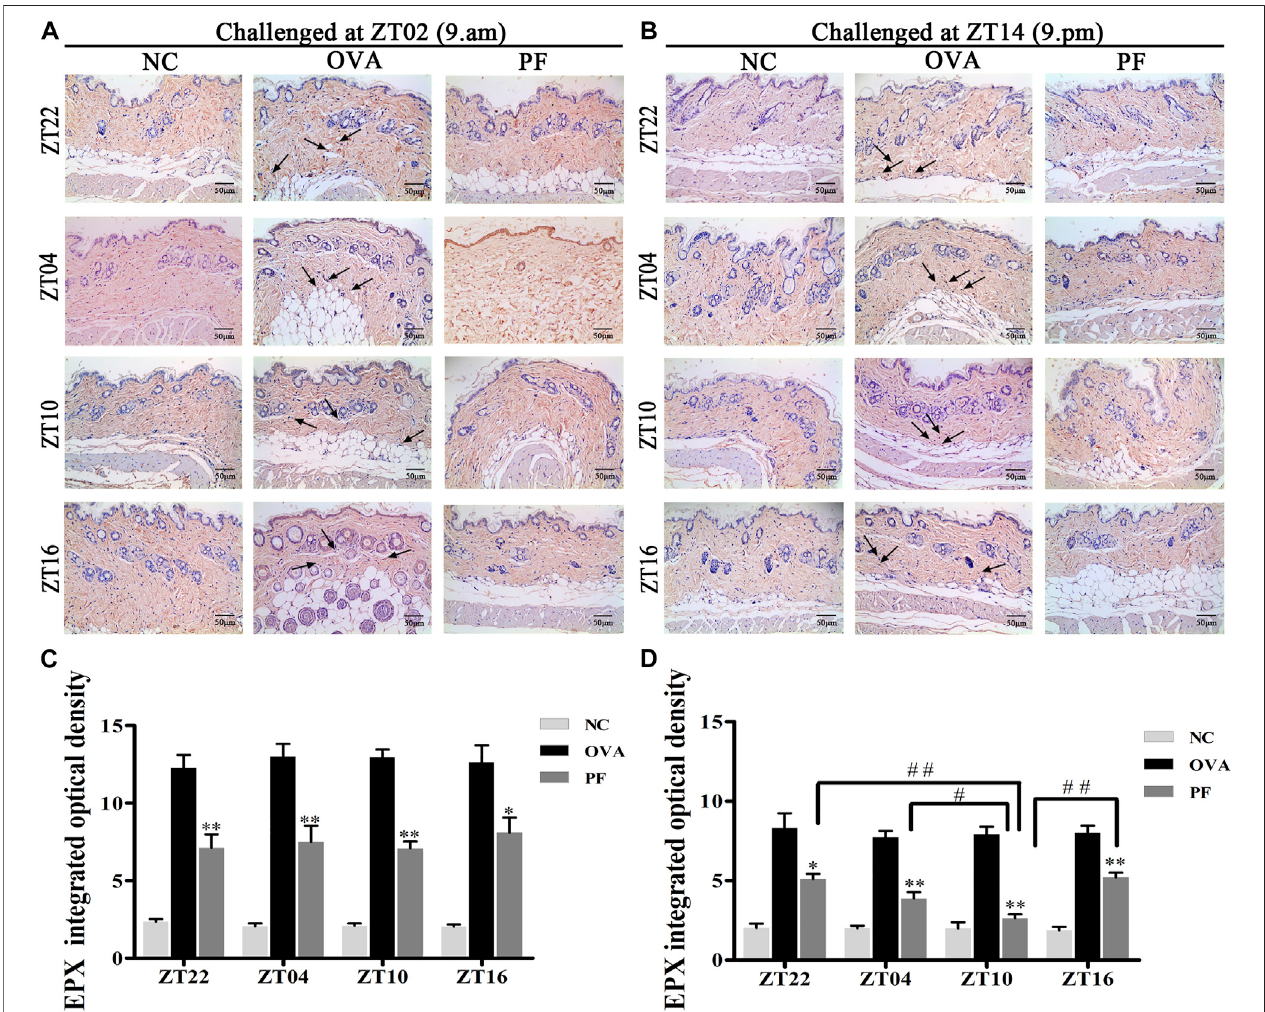
FIGURE 6 | Representative low-magni fi cation light photomicrographs (A,B) and integrated optical density (C,D) displaying immunohistochemistry of eosinophil proteinX(EPX)(blackarrows).ThePFtreatmentatZT10hadagreatereffectonEPXproduction.Dataareexpressedasmean ± SEM(n=6).* p < 0.05,** p < 0.01versus OVA mice at the same time points. # p < 0.05, ## p < 0.01 represents the comparison of PF ZT10 versus the other three PF groups. The magni fi cation was ×